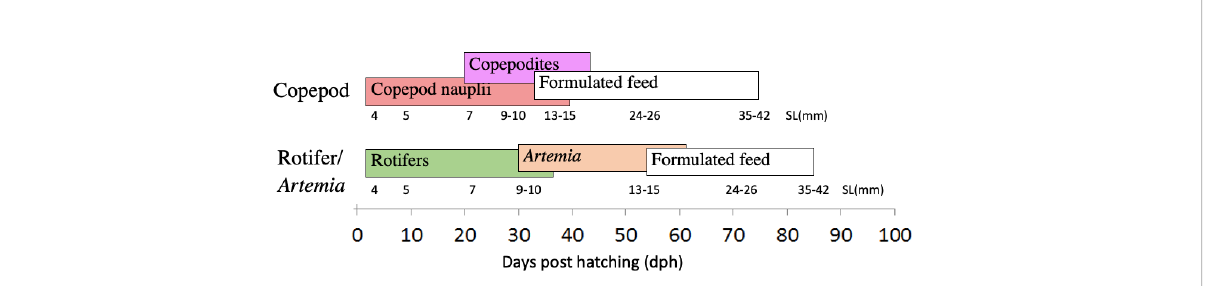
FIGURE 1 Experimental setup. Cod larvae were fed either copepods (nauplius and copepodite stages) or rotifers and Artemia , then weaned onto a commercial formulated diet from around 15 mm size. Cod larvae were sampled at corresponding larval body sizes at around 4, 5, 7, 9-10, 24-26, and 35-42 mm SL in the two